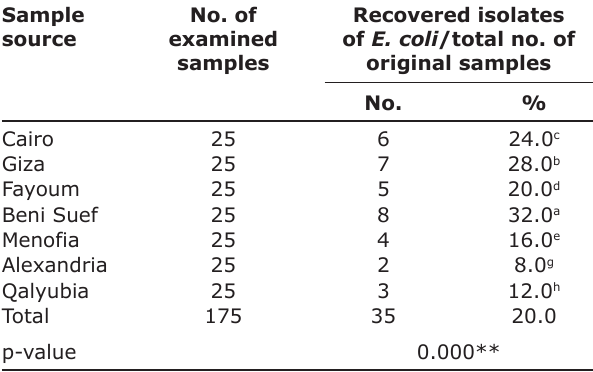
Table-7: Prevalence rates of E. coli isolates from human